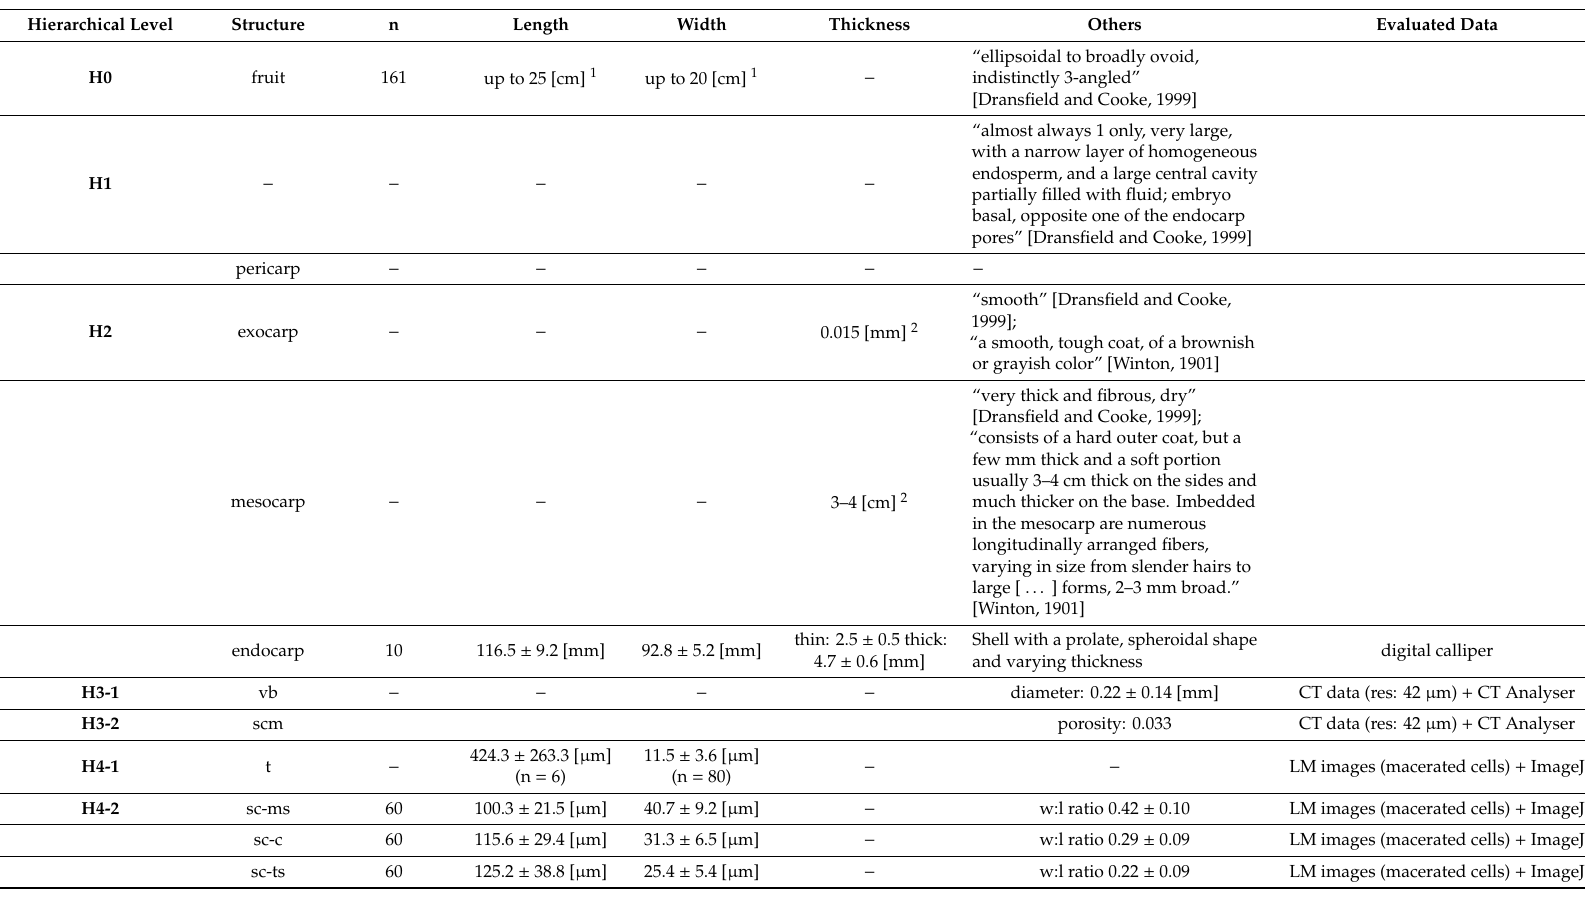
Table 1. Morphological parameters of the di ff erent hierarchical levels of the coconut fruit. Given are mean values ± standard deviation. From hierarchical level H3, only the endocarp was considered. Abbreviations: number (n), thin to thick ratio (t:t ratio), vascular bundles (vb), sclereid cell matrix (scm), resolution (res), tracheids (t), sclereid cells (sc), mesocarp side (ms), centre (c), testa side (ts), cell wall (cw), width to length ratio (w:l ratio), primary cell wall layer (l1), secondary cell wall layers (l2), pits